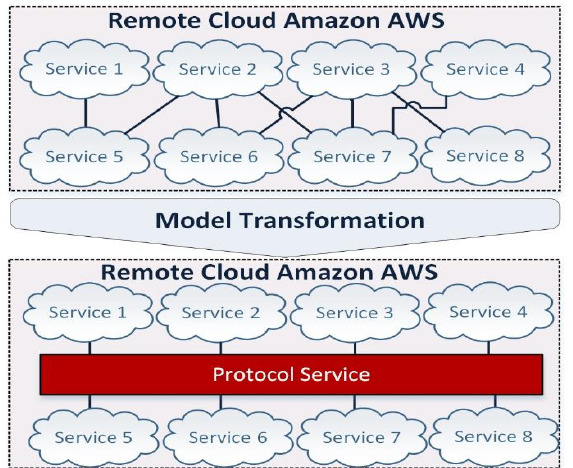
Fig. 5. The proposed Architecture with the Protocol service